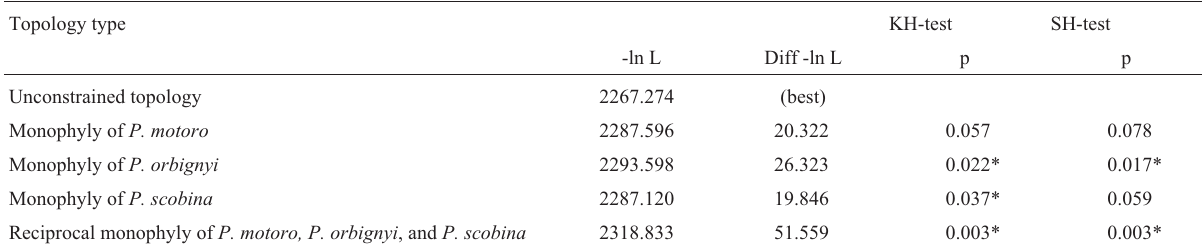
Table 4 - Results of ML constraint tests of monophyly of species Potamotrygon motoro , P. orbignyi , and P. scobina . * p < 0.05. Topology type